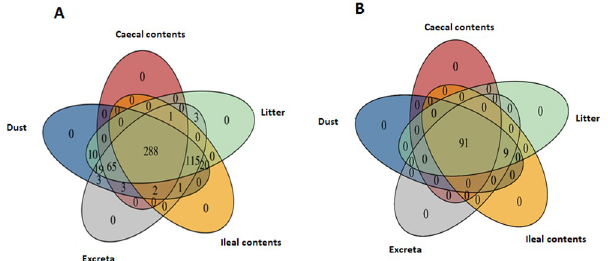
Fig 5. Venn diagram showing common bacterial OTUs between sample types A) across all OTUs and in the B) top 100 most abundant